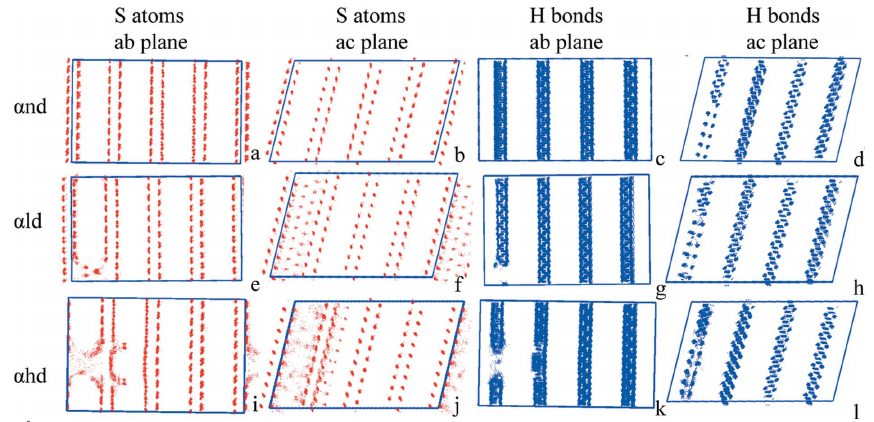
Figure 9 Distribution superposition of S atoms and hydrogen bonds of the (cid:2) polymorph with ( a )–( d ) no vacancy defects, ( e )–( h ) low vacancy-defect density and ( i )–( l ) high vacancy-defect density from 0 to 10 ns. The red dot density reflects the molecular trajectory and the blue lines represent the hydrogen bond formation. The more concentrated distribution suggests a slight movement and the discrete distribution indicates a large molecular